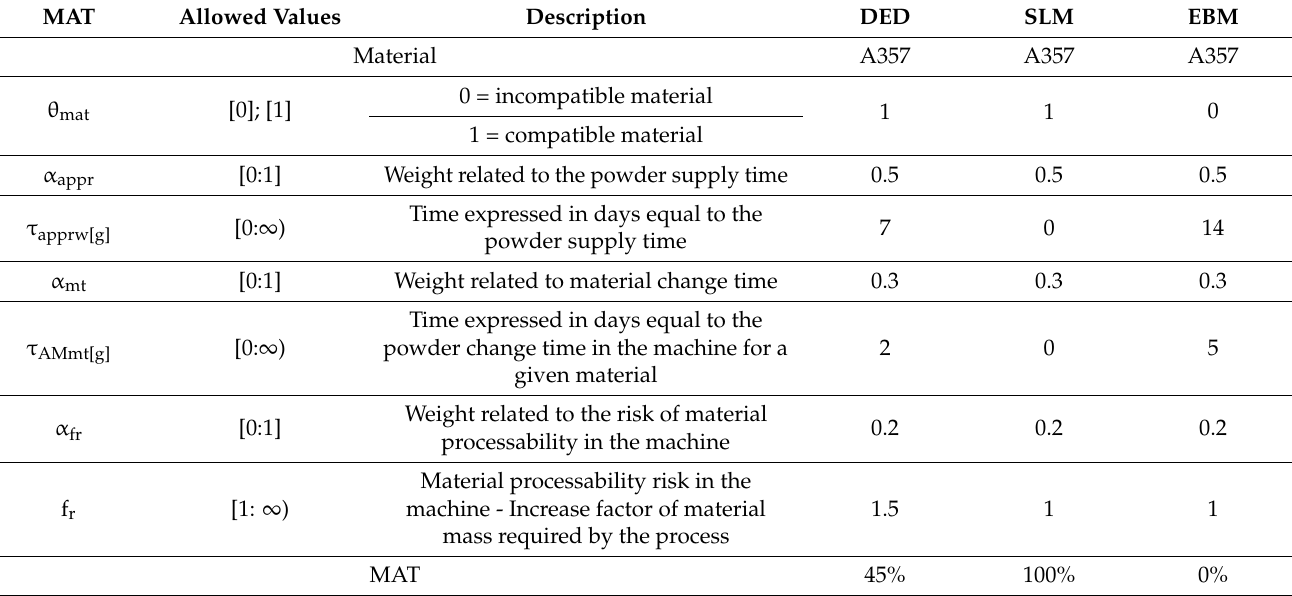
Table 2. MAT calculation for the FDM head for traditional